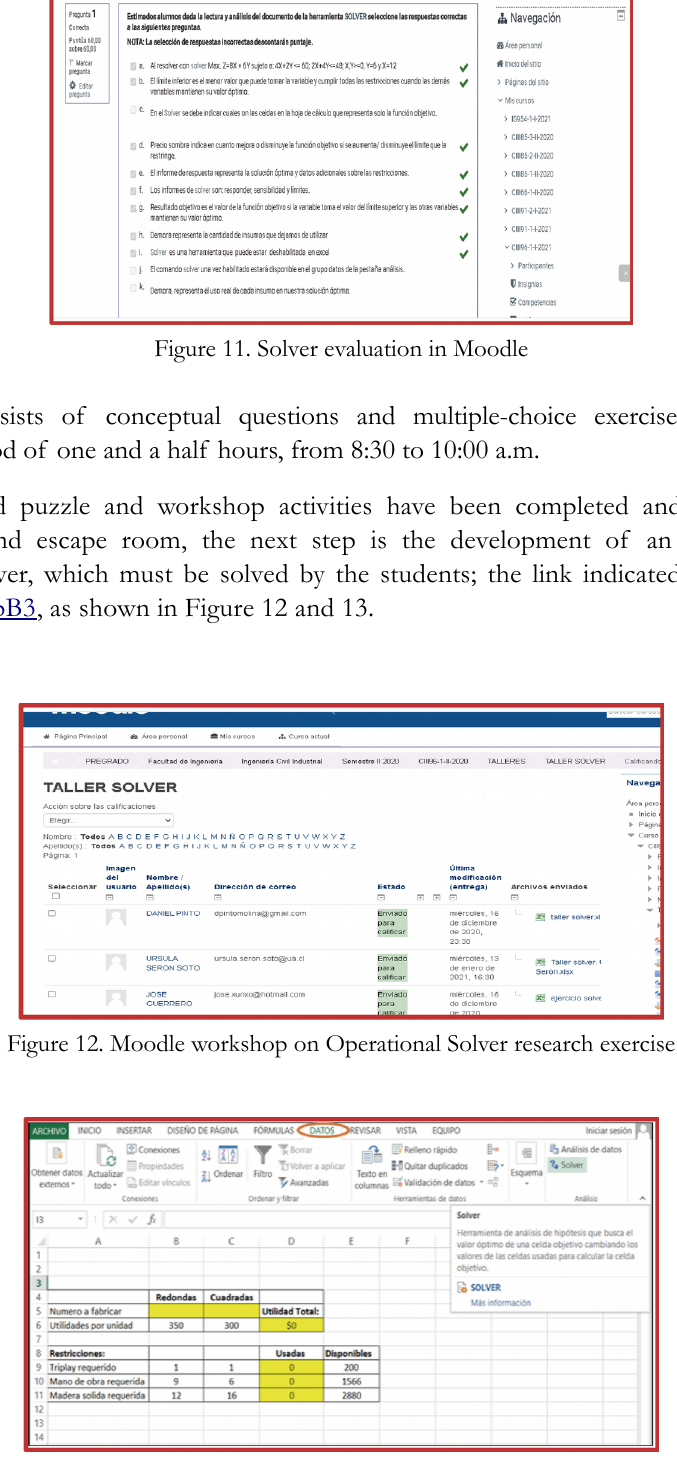
Figure 13. Solver